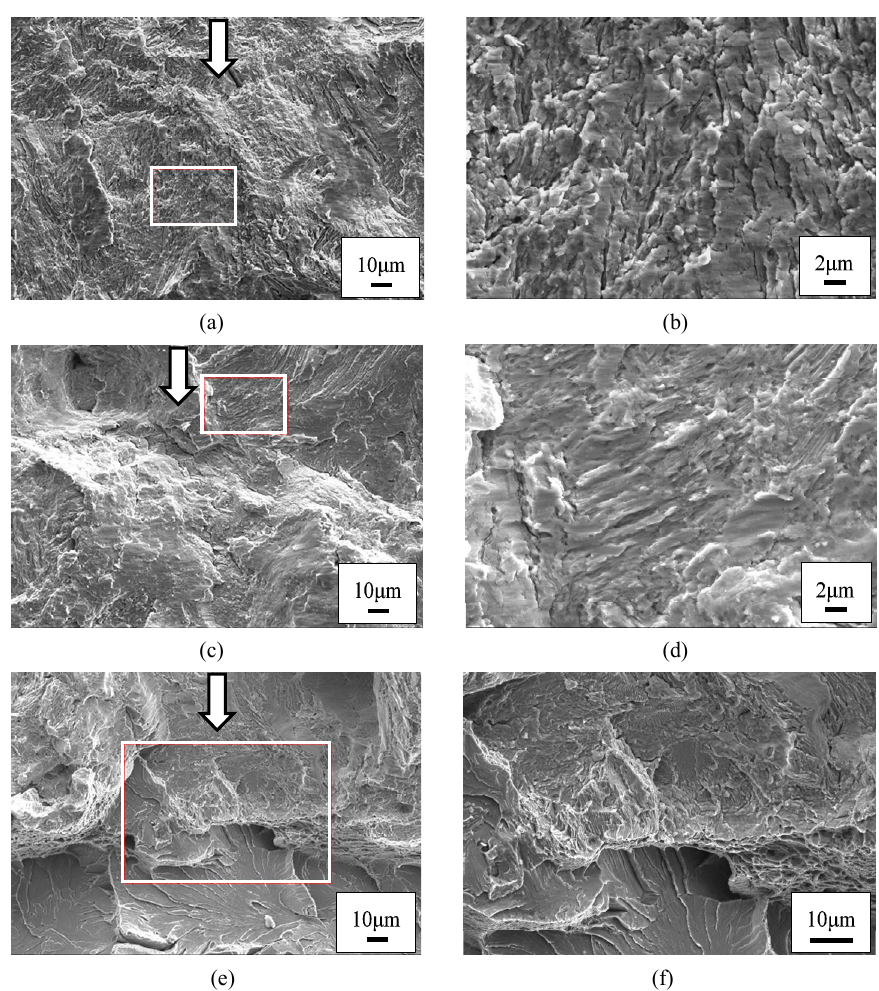
Figure 13. Fracture surface of RP1 observed via scanning electric microscope (SEM) (arrows indicate the direction of the crack growth). ( a ) 2 mm from the notch tip ( δ = 90°), ( b ) an enlarged view indicated by the frame in ( a ), ( c ) 4.8 mm from the notch tip ( δ = 30°), (d) frame in ( c ), ( e ) 10.5 mm from the notch tip ( δ = 30°), and ( f ) frame in ( e ).